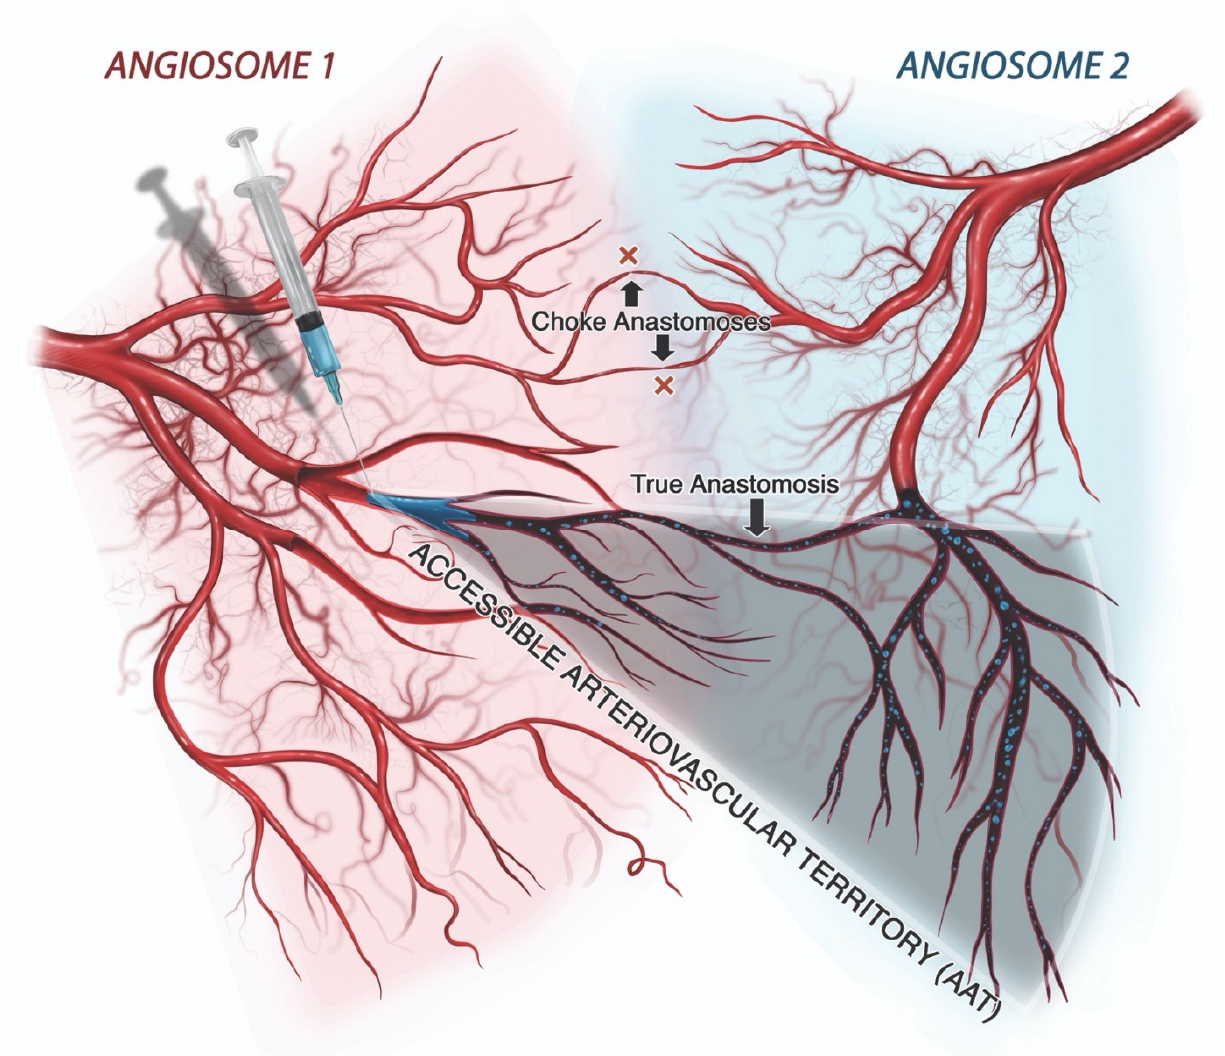
Figure 12. Conceptual illustration of the accessible arteriovascular territory (AAT). The AAT repre- sents the conglomerate of vessels and their downstream anastomotic connections into which filler particles may disseminate following accidental intravascular inoculation. The AAT may involve more than one angiosome because of the presence of true anastomoses, which serve as vascular connections linking two angiosomes or, more distally, two perforasomes. Choke vessels, which function as gatekeepers, act as dynamic anastomoses that either permit cross-perfusion of tissues or, in cases of filler-induced vascular occlusion, limit the ability of filler to spread to adjacent angiosomes through a protective vasoconstrictive